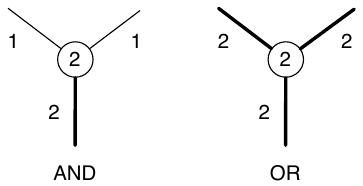
Figure 3. OR and AND gates in an NCL